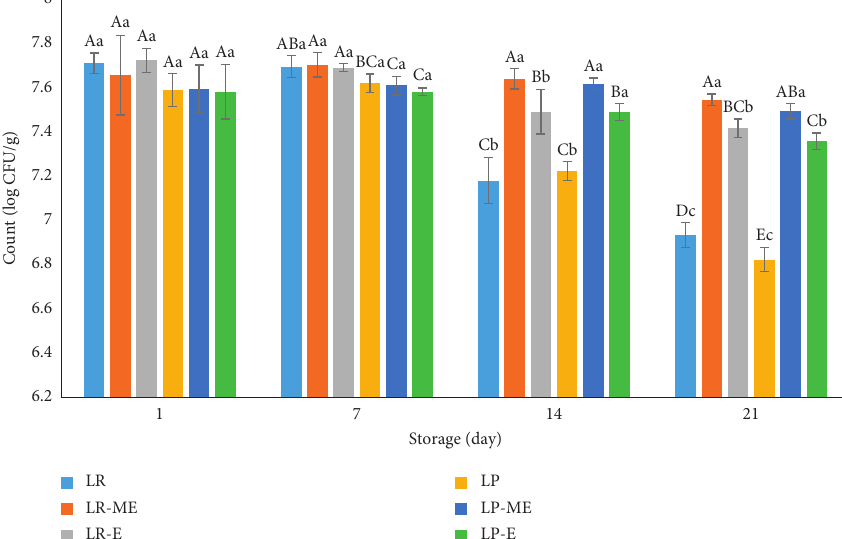
Figure 4: Viability of L. rhamnosus and L. plantarum of probiotic yogurt. LR ( L. rhamnosus ), LR-ME (encapsulated L. rhamnosus in multilayer emulsion), LR-E (encapsulated L. rhamnosus in emulsion), LP ( L. plantarum ), LP-ME (encapsulated L. plantarum in multilayer emulsion), and LP-E (encapsulated L. plantarum in emulsion). Capital letters indicate significant differences between samples at the same storage time and different time; lowercase letters indicate significant differences between the same samples at different storage